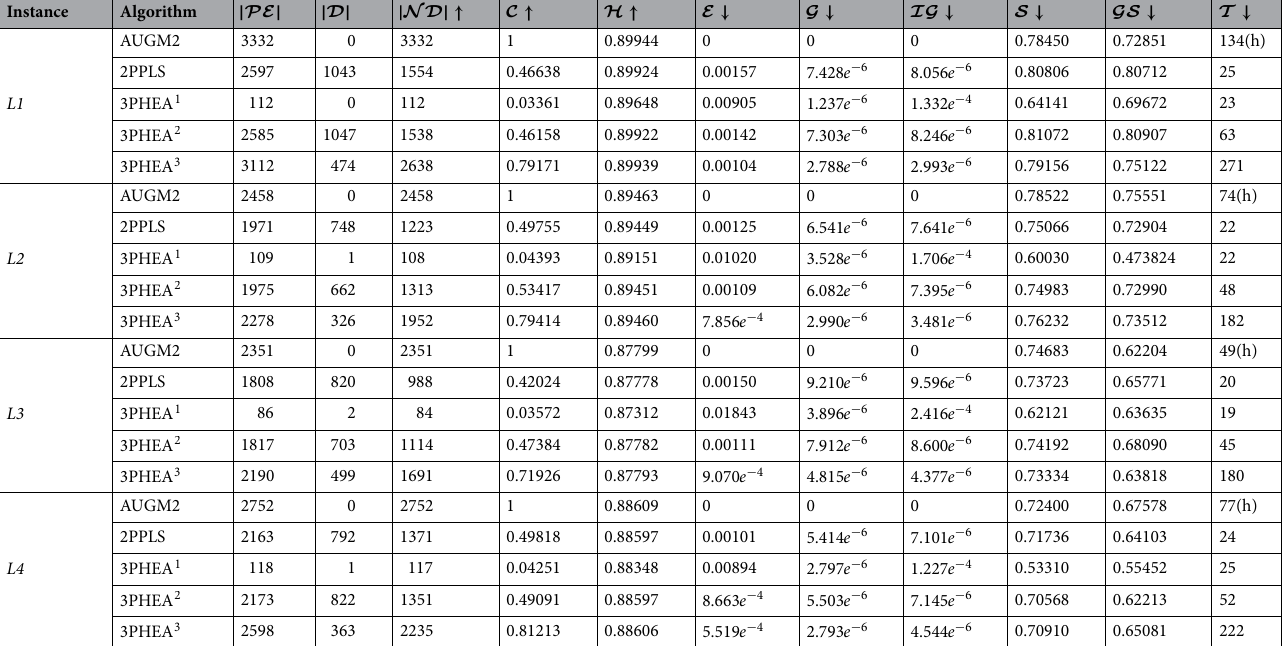
Table 3. Experimental results for datasets (Lust and Teghem 41 ). | PE | : Number of potentially efficient solutions; | D | : Number of dominated solutions; | ND | : Number of nondominated solutions; C : Coverage metric; H : Hypervolume; E : Epsilon indicator; G : Generational distance; IG : Inverted generational distance; S : Spread; GS : Generalized Spread; T : Time in seconds unless